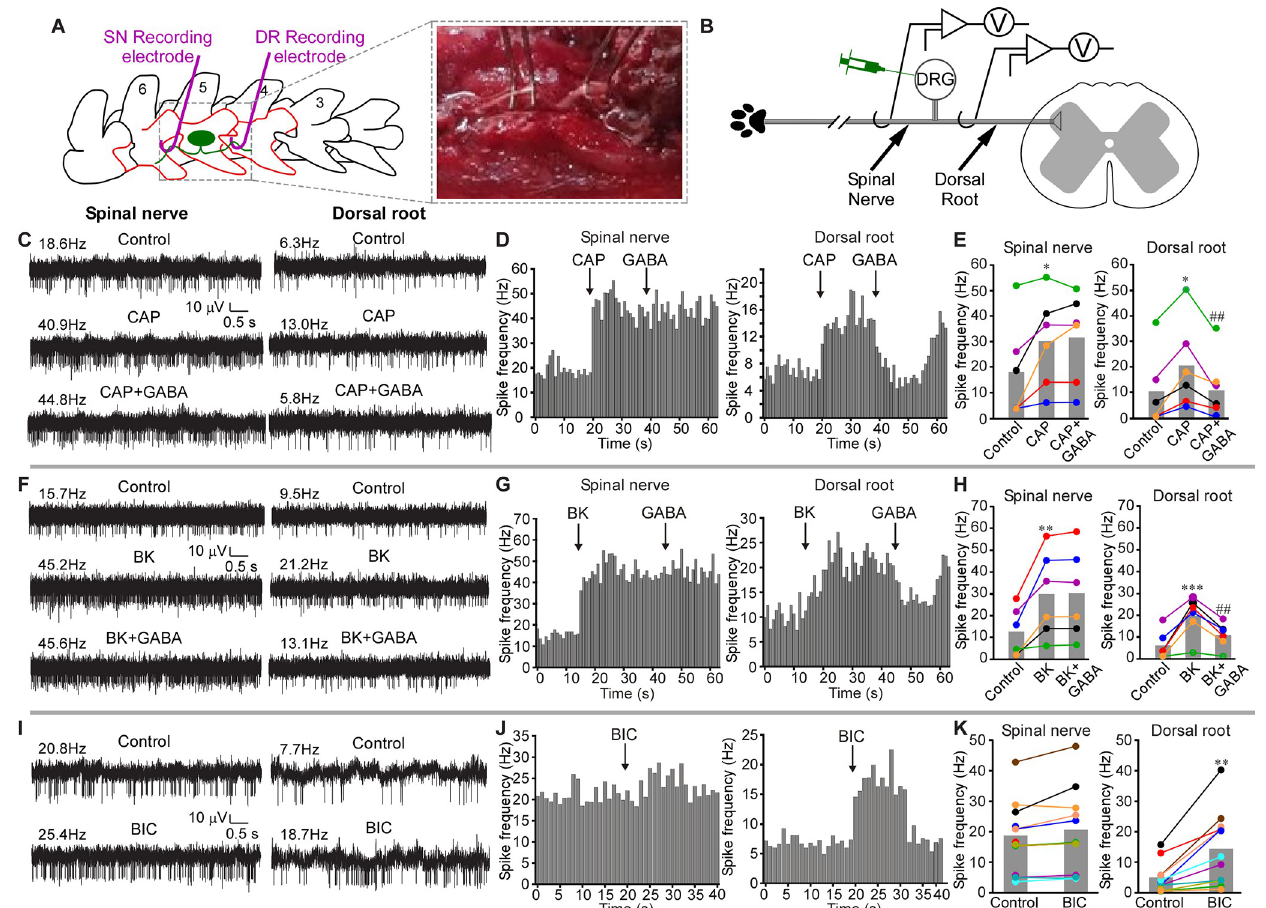
Fig 1. GABAergic filtering of nociceptive signals at the DRG. ( A ) Schematic of surgical exposure of the L5 SN (left), L5 DRG, and the DR (middle) in an anesthetized rat. Parts of the vertebra that are surgically removed are shown in orange. SN and DR are then individually suspended on fine hook electrodes; DRG is exposed to direct drug application. ( B ) Schematic of the electrode placement. ( C ) Hindpaw injection of Capsaicin (CAP, 10 μ M, 50 μ l) increased firing frequency in both SN and DR branches of the nerve (middle traces, as compared to basal activity shown in the upper traces). Application of GABA (200 μ M, 3 μ l) to DRG reduced CAP-induced firing frequency in DR but not SN (bottom traces). ( D ) Histograms of firing frequencies from panel C. ( E ) Summary of experiments as in panel C. Two-factor repeated measures ANOVA, with factors of nerve site (SN, DR) and drug treatment (Control, CAP, CAP +GABA) revealed main effects associated with nerve site [F(1,10) = 15.1; p < 0.05] and drug application [F(2,9) = 12.8; p < 0.05], and there was significant interaction between these factors [F(2,9) = 7.9; p < 0.05]. Bonferroni post hoc test: � significant difference from control ( p < 0.05); ## significant difference from CAP ( p < 0.01). ( F–H ) Similar to C–E, but Bradykinin (BK, 100 μ M, 50 μ l) was hindpaw injected, instead of CAP. ( H ) Two-factor repeated measures ANOVA: main effect associated with drug application [F(2,9) = 12.0; p < 0.05]; significant interaction between nerve site and drug application [F(2,9) = 11.5; p < 0.05]. Bonferroni post hoc test: �� , ��� significant difference from control ( p < 0.01, p < 0.001); ## significant difference from BK ( p < 0.01). ( I–K ) GABA A antagonist bicuculline (BIC, 200 μ M, 3 μ l) was applied to DRG instead of GABA; hindpaw was not stimulated. ( K ) Two-factor repeated measures ANOVA: main effects associated with nerve site [F(1,20) = 7.7; p < 0.05], drug application [F(1,20) = 12.0; p < 0.01], significant interaction between nerve site and drug application [F(1,20) = 18.7; p < 0.01]. Bonferroni post hoc test: �� significant difference from control ( p < 0.01). Metadata for quantifications presented in this figure can be found at https://archive.researchdata.leeds.ac.uk/1042/. Schematics are drawn with Canvas X 2019. DR, dorsal root; DRG, dorsal root ganglion; SN, spinal